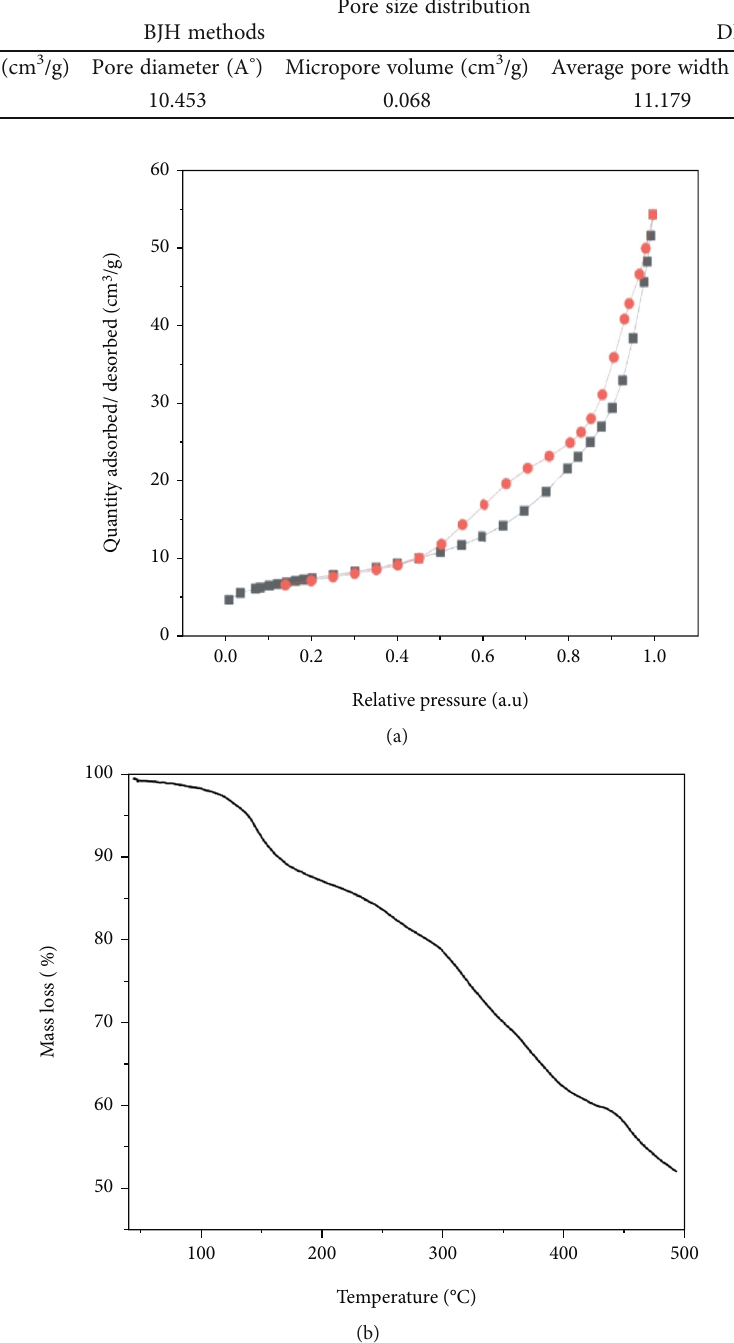
Figure 3: Characterization of hydrogel: (a) BET surface area and (b) thermogram.